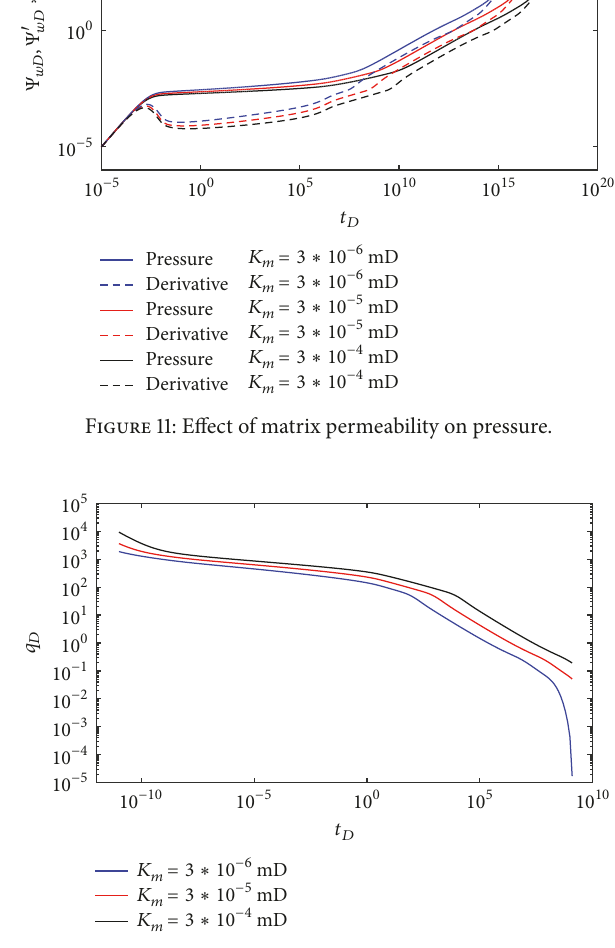
Figure 12: Effect of matrix permeability on